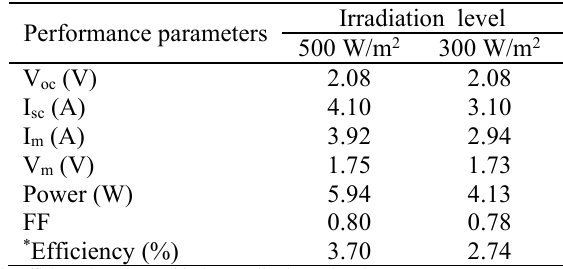
Figure 4. I-V and P-V characteristics of clean PV module without reflector Table 1. Electrical performance parameters of clean PV module without